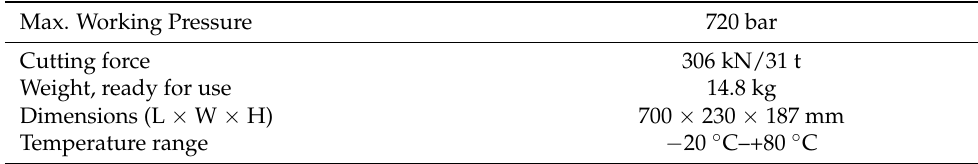
Table 1. Technical parameters Holmatro, CU 3035 NCT [37].